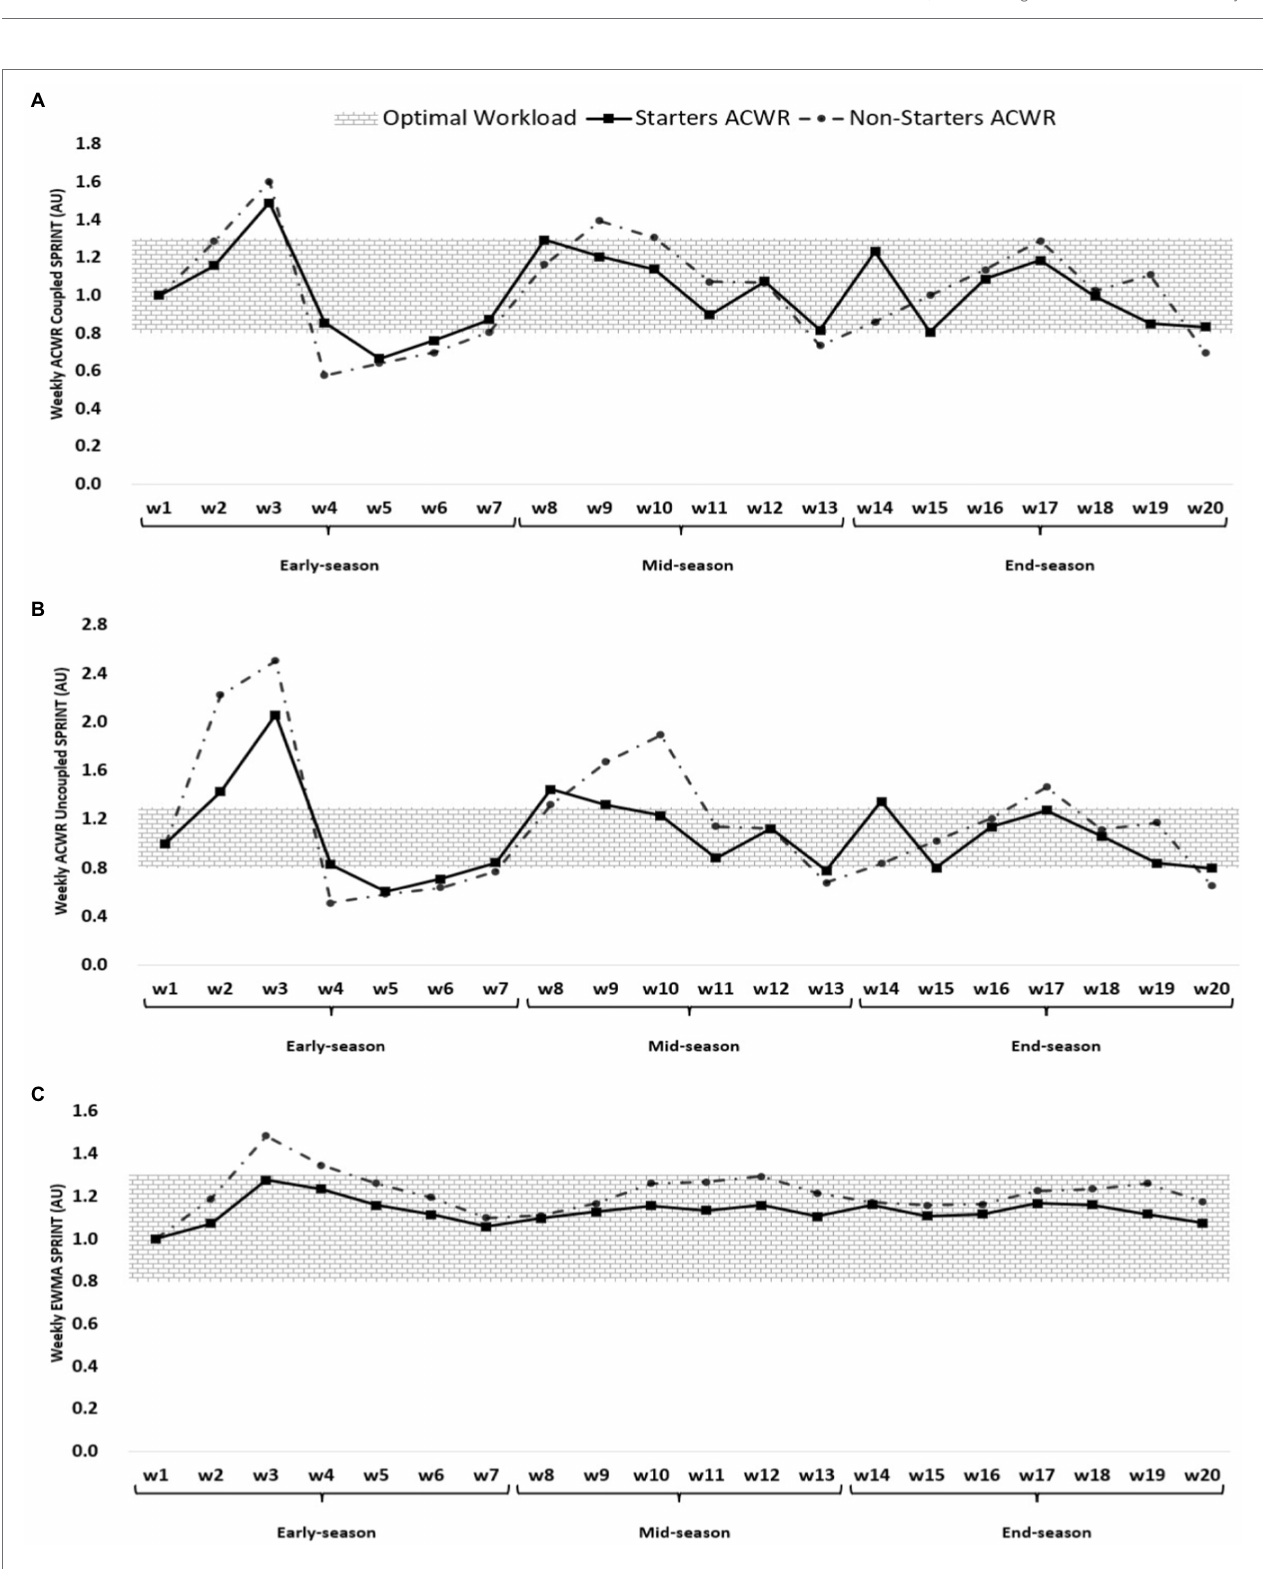
FIGURE 4 | ACWR coupled (A) and uncoupled (B) , and EWMA (C) variations calculated through the sprint distance across 20-week starters and